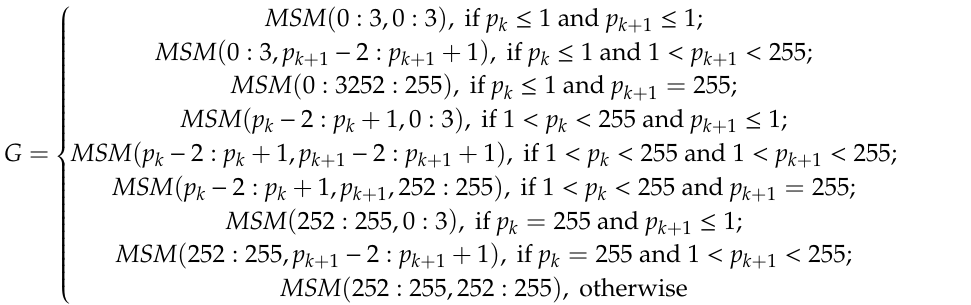
Figure 5. Candidates of embedding for different combinations of (cid:1828) (cid:2870) and (cid:1828) (cid:2871) .